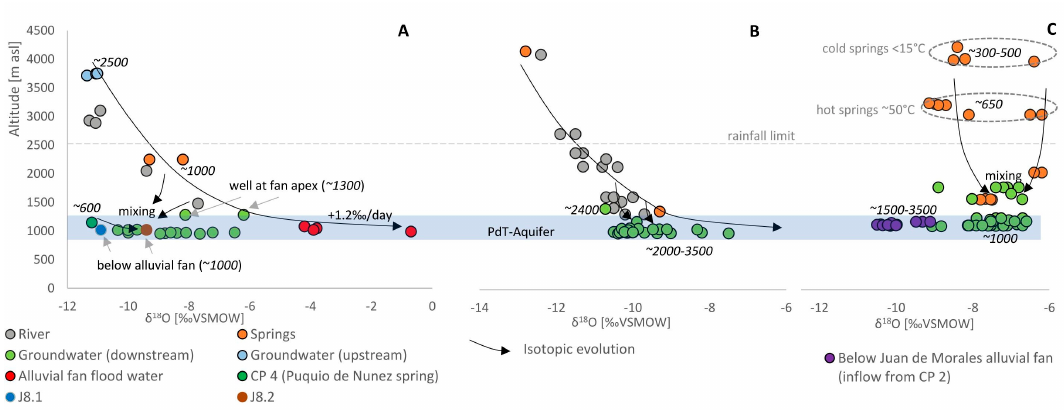
Figure 5. δ 18 O against sample altitude (river, spring and groundwater) of different compartments (CP), ( A ) CP 5, Chacarillas basin, ( B ) CP 2, Tarapacá river, ( C ) CP 3, Juan de Morales river. Italic numbers indicate electrical conductivities of spring and groundwater in µS/cm.